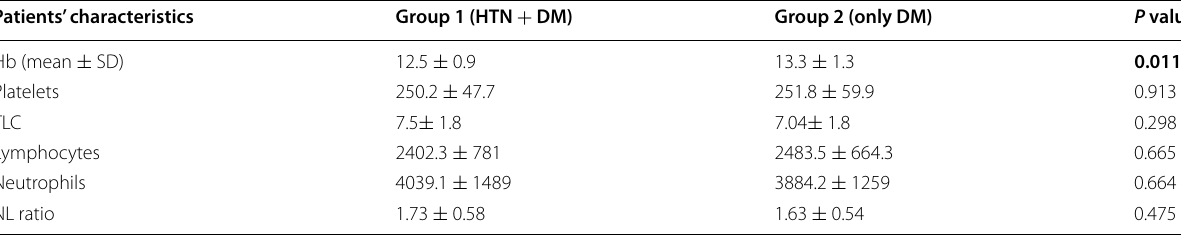
Table 2 Laboratory data of the patients’